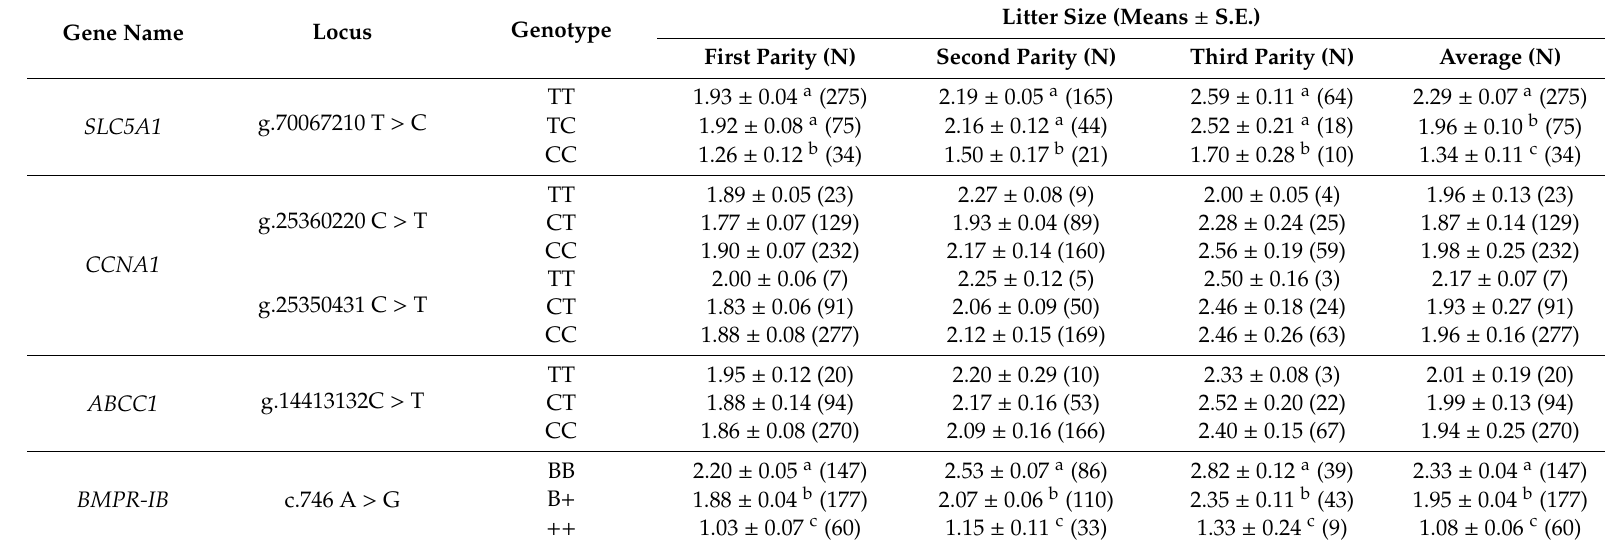
Table 3. Associations between the genotypes of the single nucleotide polymorphisms (SNPs) and litter size in Small-Tail Han